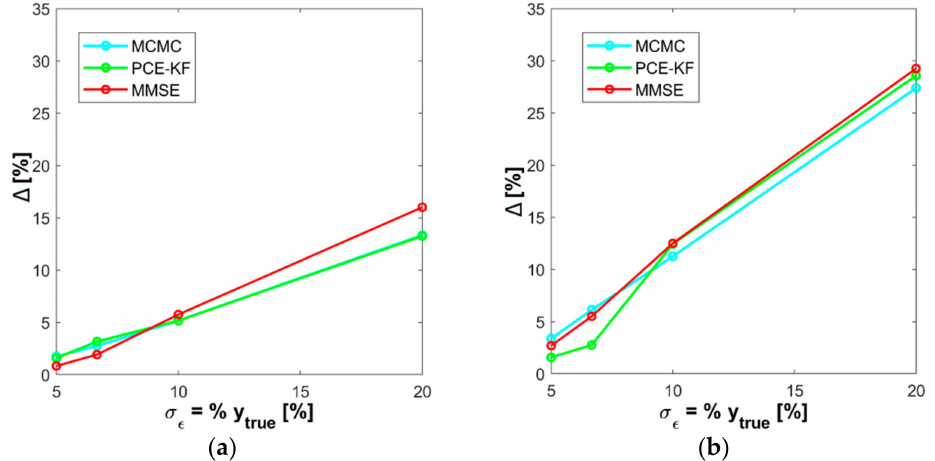
Figure 8. Percentage error in the updating according to different methods, variations with measure- ment error: ( a ) EJ true = m + s = 1.2 and ( b ) EJ true = m + 3 s = 1.6. Results are compared for the MCMC method (in cyan), the PCE-KF method (in green) and the NL-MMSE method (in